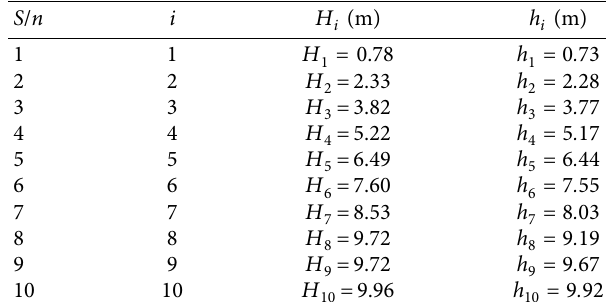
Figure 6: Design scheme for the nonzero staircase reference. Table 1: Calculation of switching angles. Table 3: Computation of heights of nonstaircase modulating